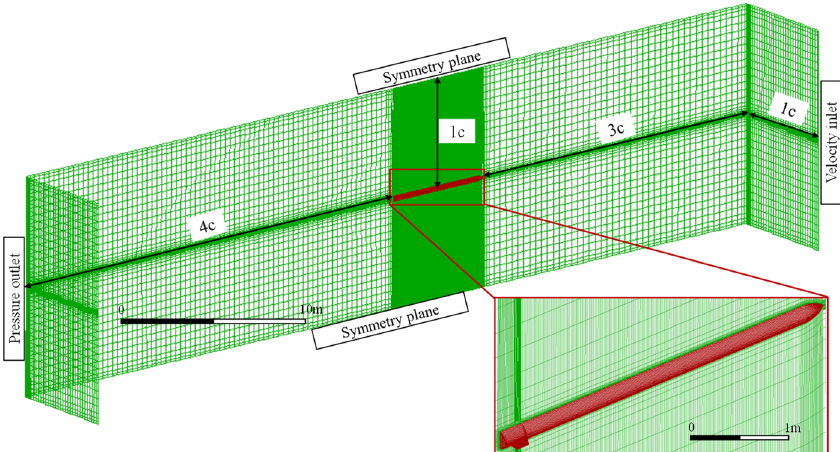
Figure 13. Computational mesh and boundary conditions.